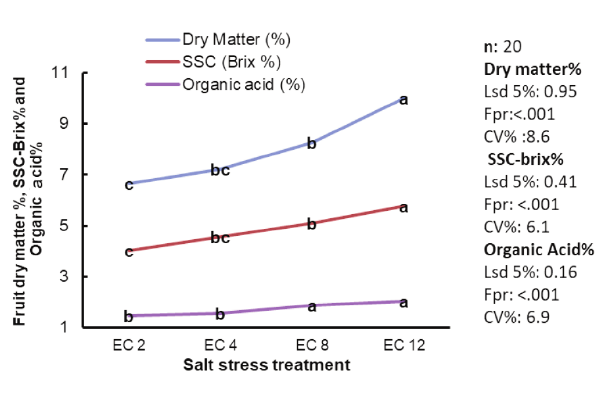
Fig. 1 ­ Effect of different concentration of “onsen” water on fruit SSC Brix%, dry matter and organic acid of tomato plants variety ‘Reika’ in the greenhouse.